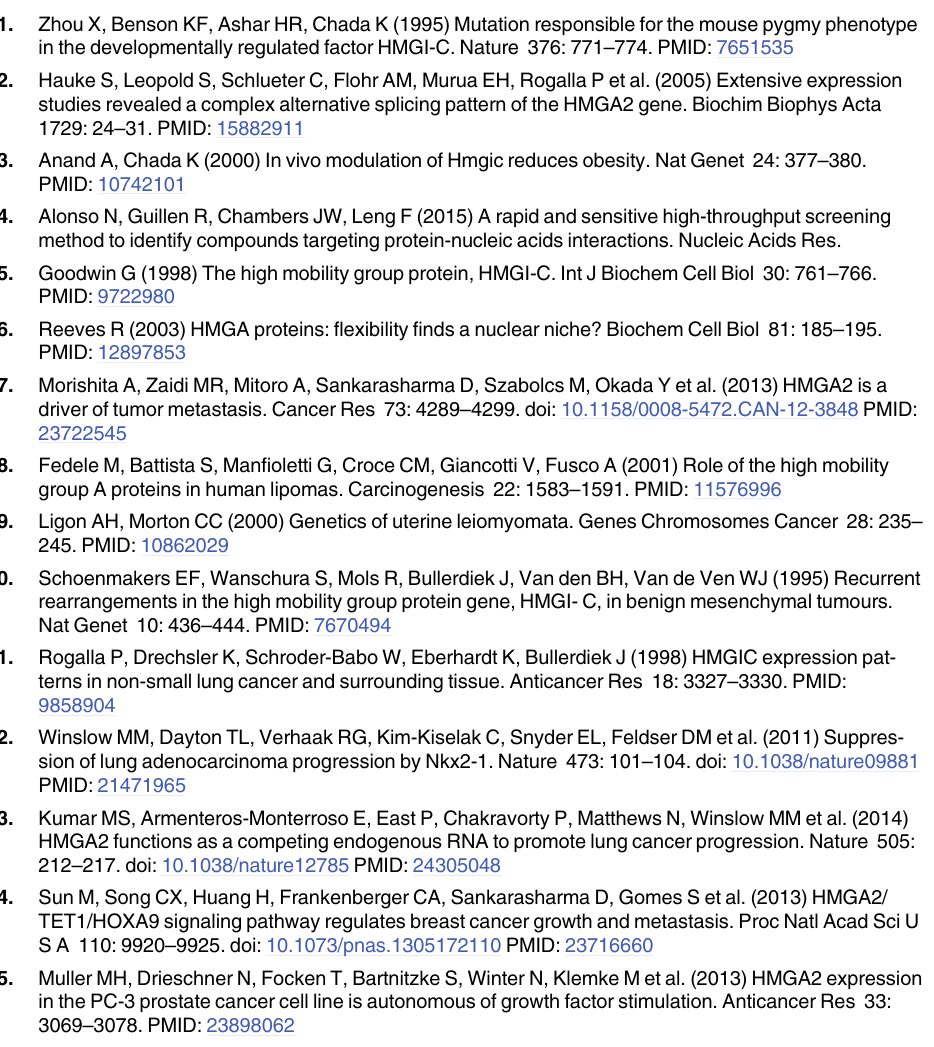
S2 Table. Results for individually fitting the sedimentation velocity data to the model of a single ideal species by the program Sedanal (version